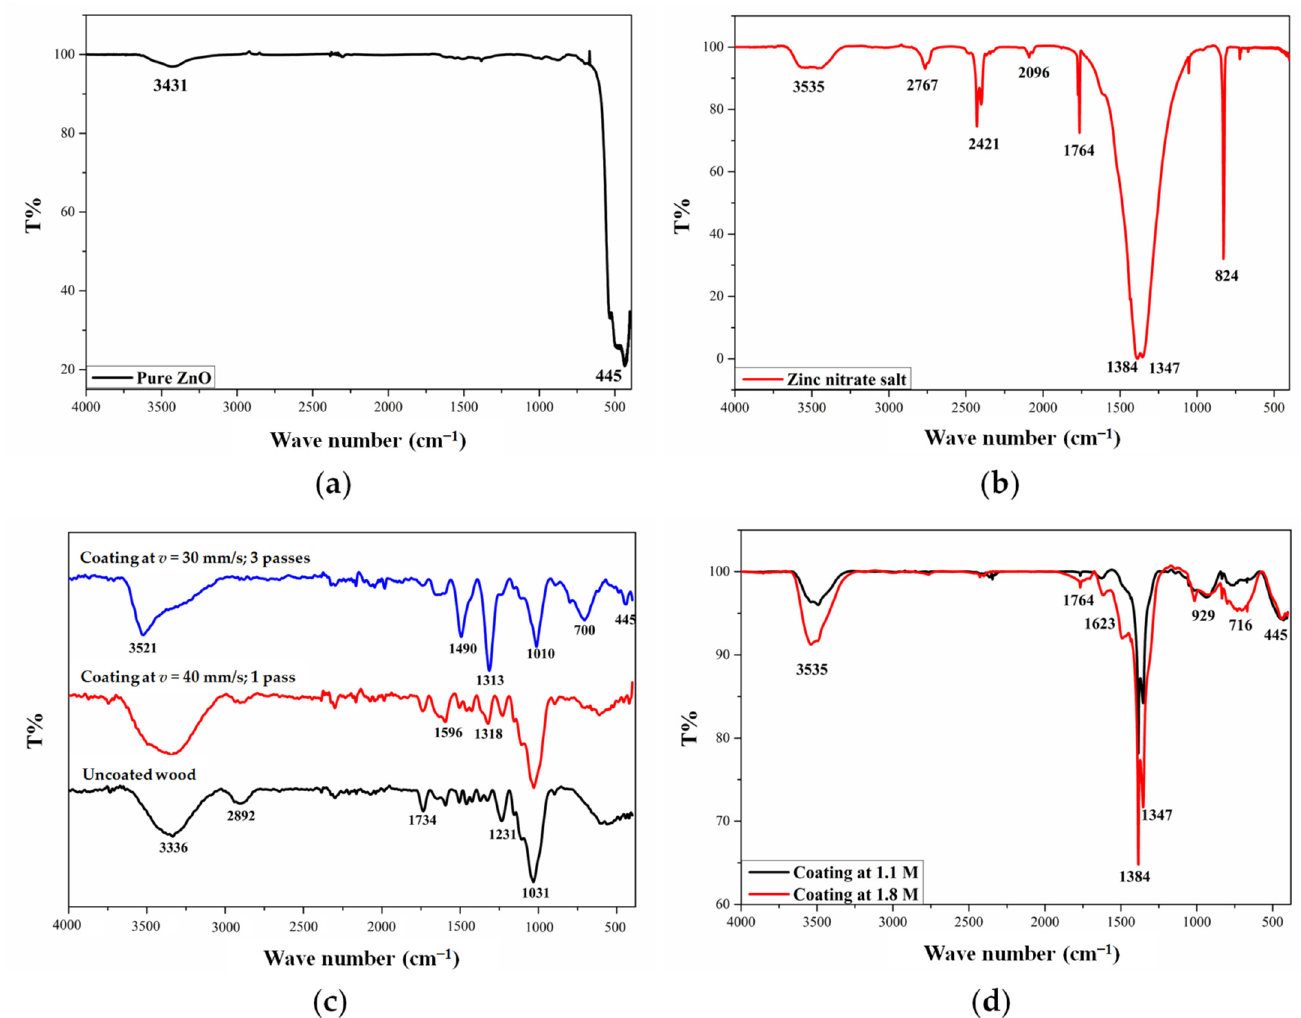
Figure 5. ( a ) Fourier transform infrared spectroscopy (FTIR) spectrum of the pure ZnO, ( b ) FTIR spectrum of the zinc nitrate hexahydrate salt, ( c ) FTIR–ATR (attenuated total reflectance) spectra of the uncoated and coated wood samples, ( d ) FTIR spectra of the coatings.